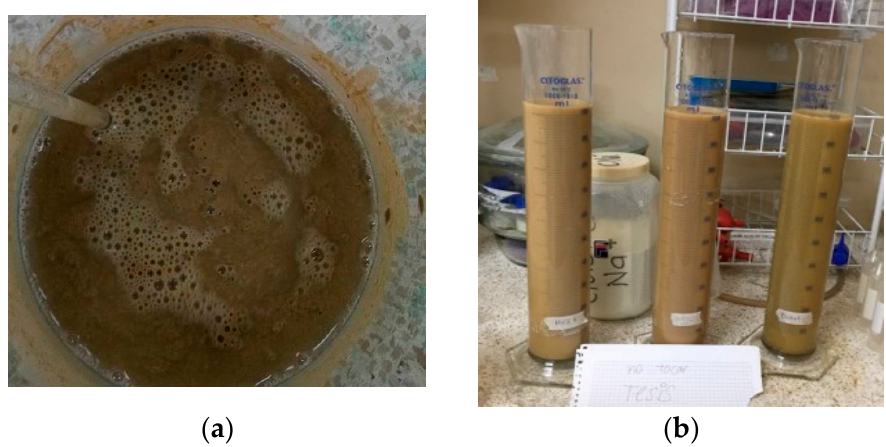
Figure 5. Calcium nontronite purification treatment. ( a ) Removal of organic matter, ( b ) gravimetric separation (Stokes’ Law).